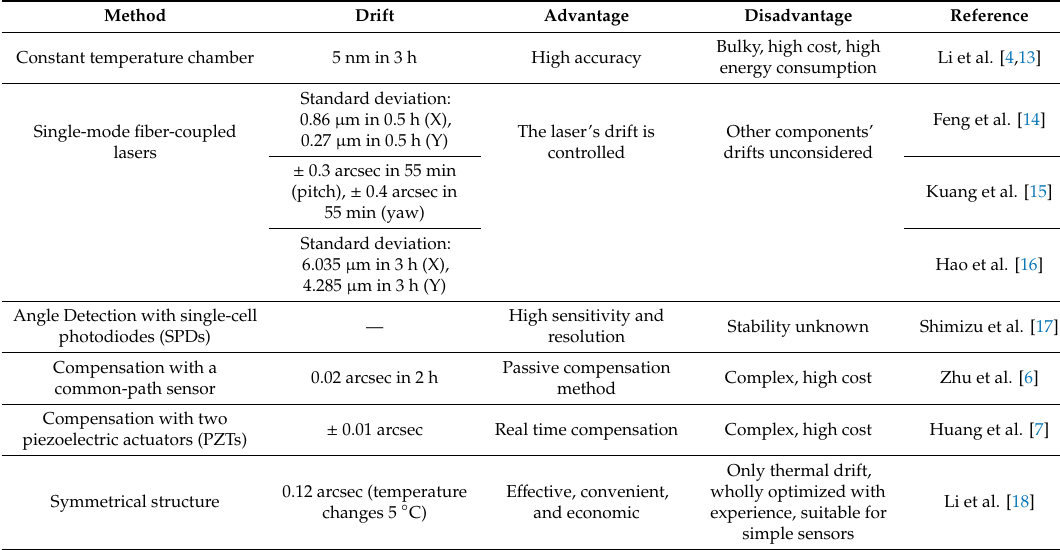
Table 1. Comparison of previous methods for reducing